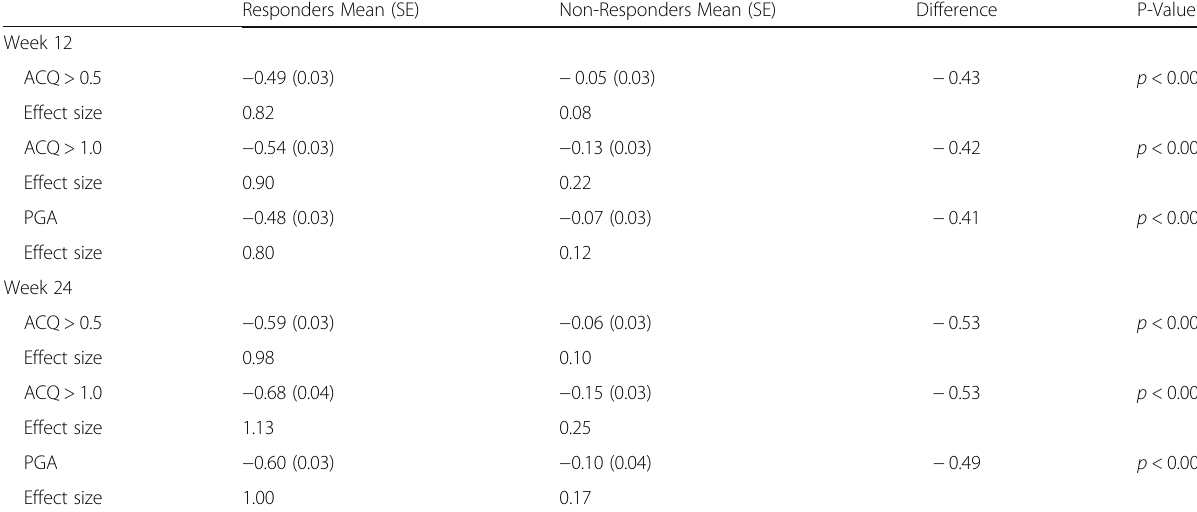
Table 1 Responsiveness of the Average 7-Day ASD Score at Weeks 12 and 24